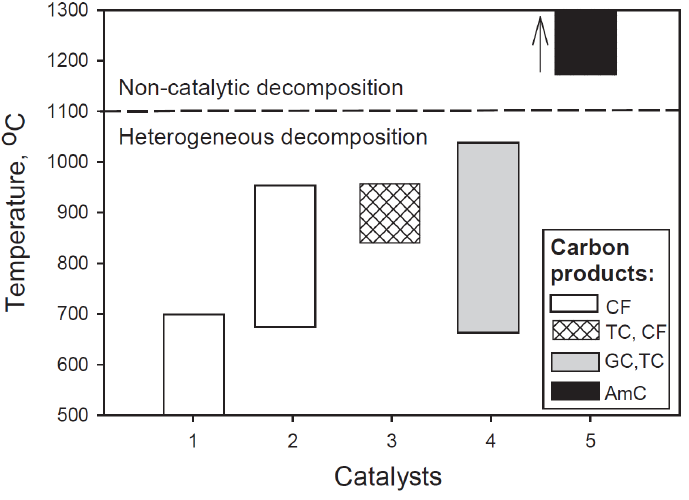
Figure 1. Graphical representation of the bulk of literature data on catalysts, preferred temperature range and carbon products related to catalytic methane decomposition reaction. Catalysts: 1-Ni-based, 2-Fe-based, 3-carbon-based, 4-summary of data related to Co, Ni, Fe, Pd, Pt, Cr, Ru, Mo, W catalysts, 5-non-catalytic decomposition. Carbon products: CF-carbon filaments, TC-turbostratic carbon, GC-graphitic carbon, AmC-amorphous carbon. (Copied from Ref. [12] with Elsevier permission).